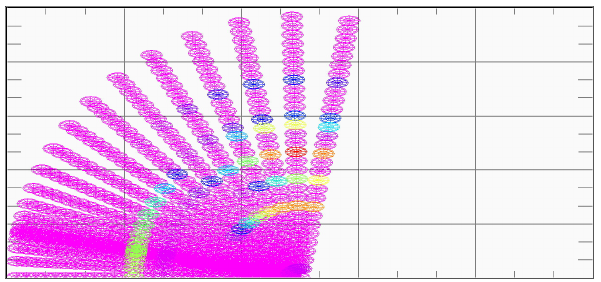
Figure 13. Polar coordinate raster focused on an object at angle α = 8 ◦ from the base plane, and with low resolution